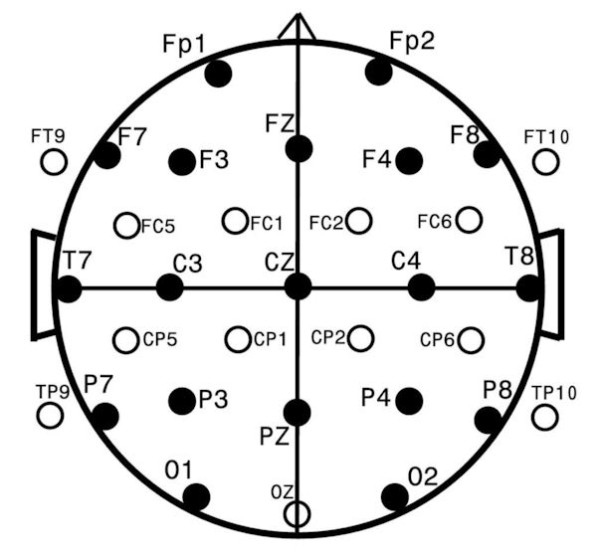
Standard EEG electrode names and positions. Head in vertex view, nose above, left ear to left. EEG electrodes: Z: Midline: FZ: Midline Frontal; CZ: Midline Central; PZ: Midline Parietal; OZ: Midline Occipital. Even numbers, right hemisphere locations; odd numbers, left hemisphere locations: Fp: Frontopolar; F: Frontal; C: Central; T: Temporal; P: Parietal; O: Occipital. The standard 19, 10–20 electrodes are shown as black circles. An additional subset of 17, 10–10 electrodes are shown as open circles.